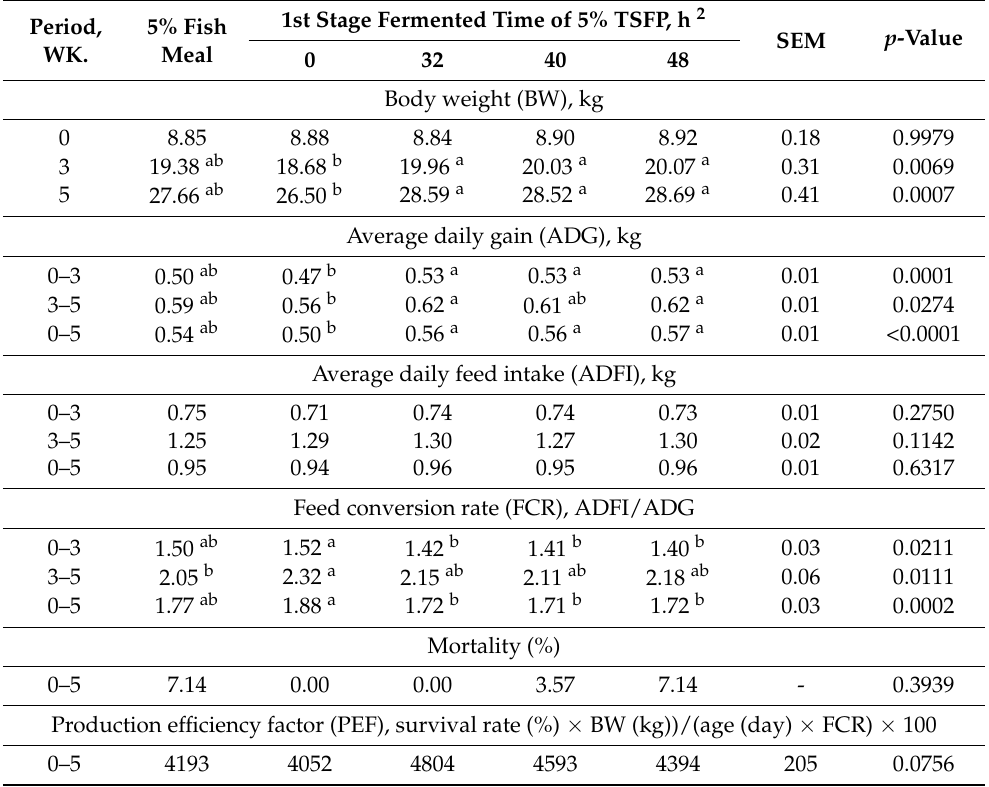
Table 4. Effect of modified TSFP 1 on the growth performance of nursery pigs in trial 1.